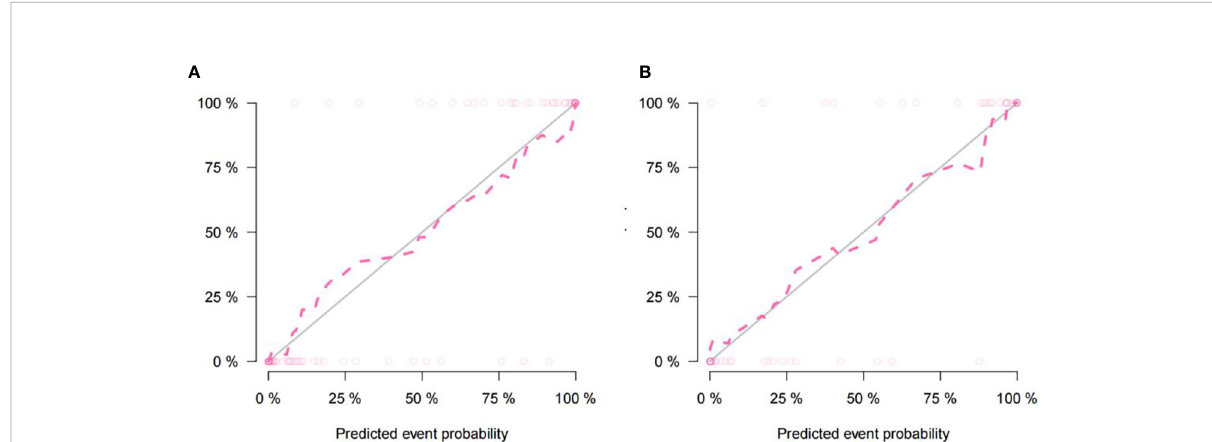
FIGURE 8 The nomogram calibration curve of the training cohort (A) and the validation cohort (B) showing the relationship between the predictive and true values. The distance between the dotted line and the solid line indicated the prediction ability of the model, with an inverse relationship between the distance and prediction ability.